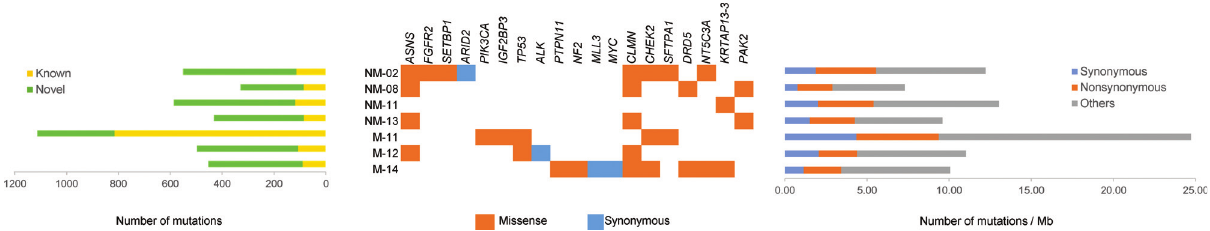
Figure 2 - Mutational landscape of HNSCC tumours. Left panel: Number of mutations (known and novel) in HNSCC patients Middle panel: significant somatic nucleotide variants (synonymous, nonsynonymous missense) Right panel: Rate of synonymous, nonsynonymous and other (3’ UTR, 3’ flank, 5’ UTR, 5’ flank, intron, splice site) mutations expressed in mutations per megabase of covered target